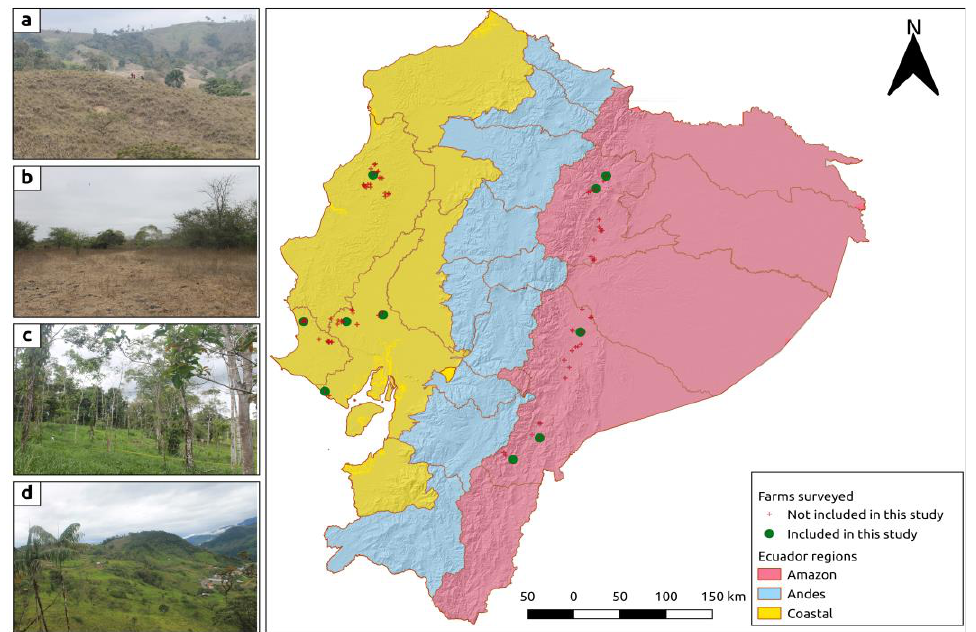
Figure 1. The central map shows the farm distribution studied in Ecuador. The small inset images show typical examples of pasture areas in hilly and flat sites that can be found in coastal ( a , b ) and Amazon ( c , d ) regions, respectively.